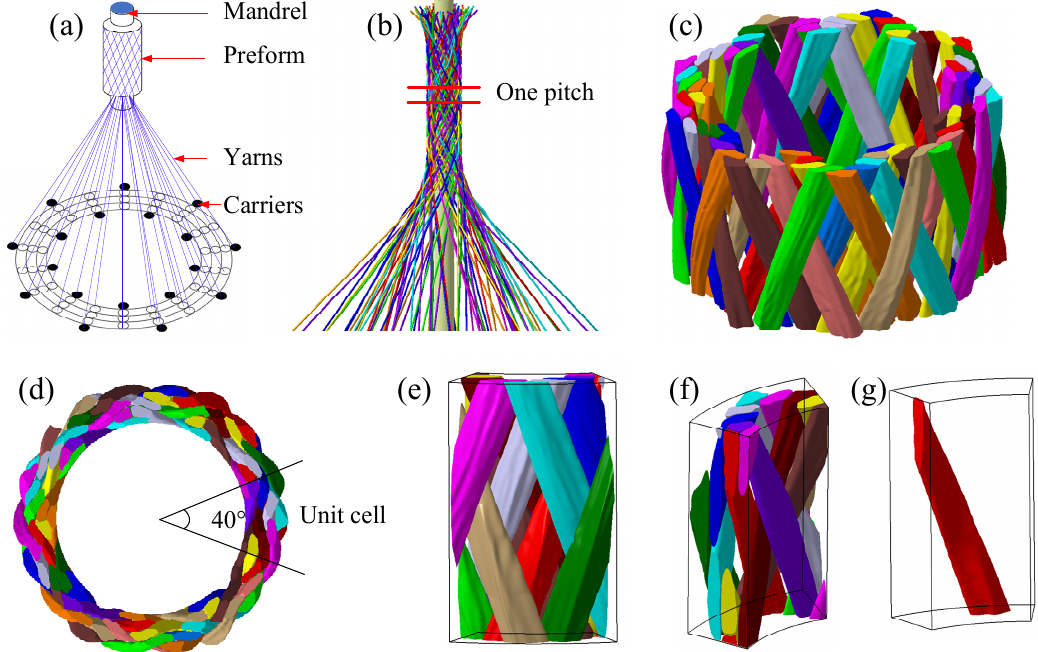
Figure 15. Simulation result of the 3D four-directional cylindrical braiding composite: ( a ) schematic of a cylindrical braiding machine, ( b ) the braiding process simulation result, ( c ) the mesostructure after deformation simulation, ( d ) the top view of one pitch, ( e ) the outside view of an RVE, ( f ) the inside view of an RVE, and ( g ) the deformational yarn.